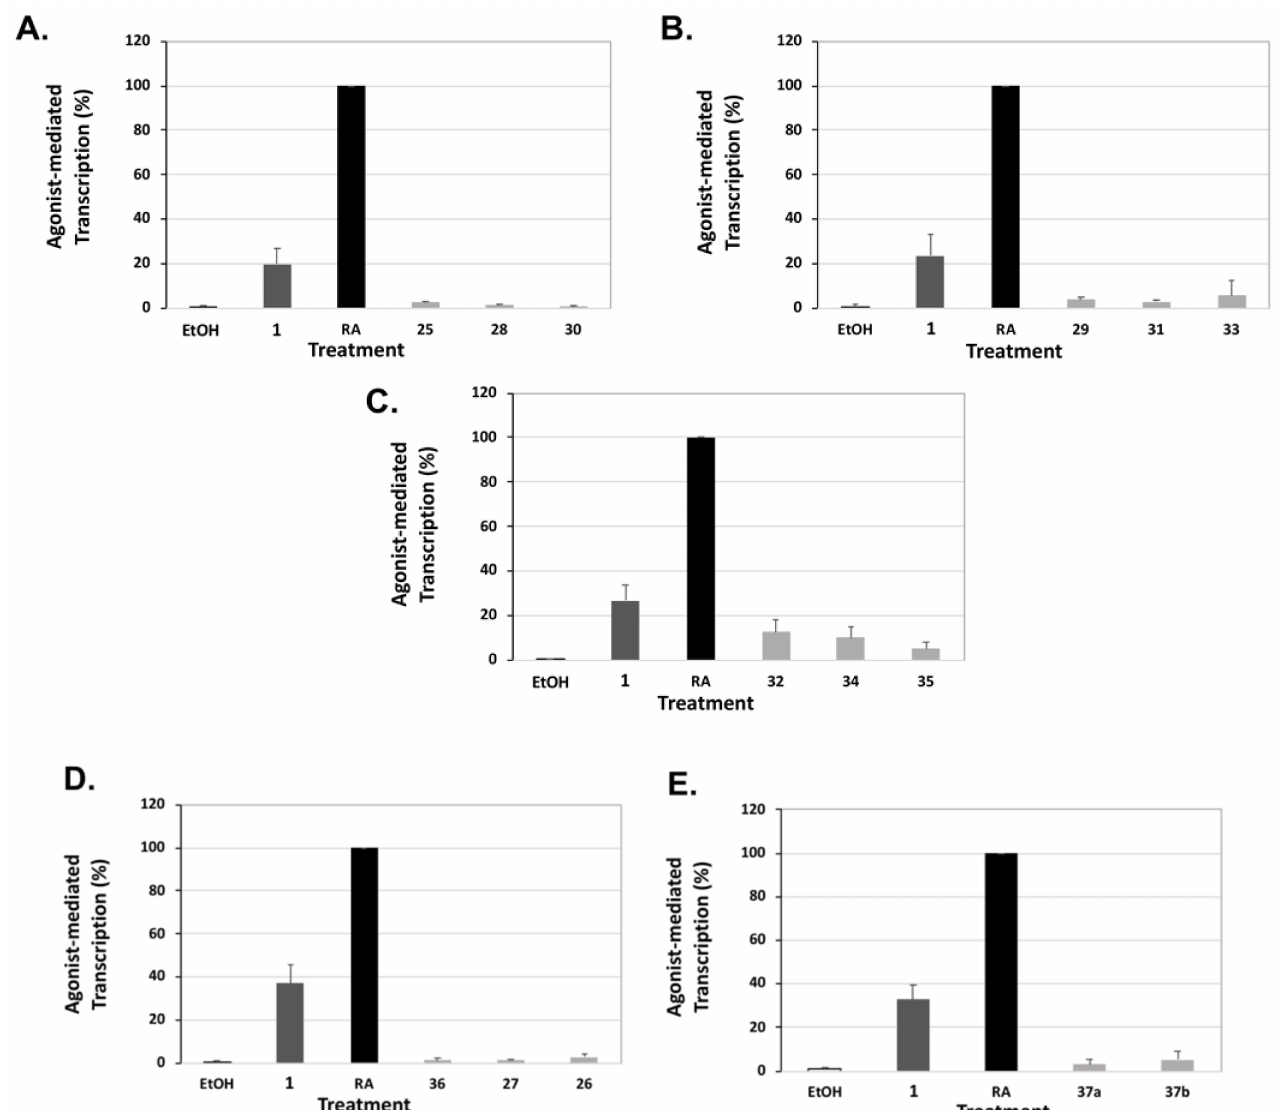
Figure 10. Assessment of RXR agonists via a RARE-luciferase reporter based assay in human cells. ( A – E ) Human embryonic cells (HEK293) were co-transfected with expression vectors for hRXR α , a RARE-luciferase reporter gene, and a renilla control plasmid for 24 h utilizing a liposome-mediated transfection protocol. Cells were treated with bexarotene, analog, or all-trans-retinoic acid (RA) at 10 nM for 24 h. The RARE activity for RA was set to 100%. Values are means ± SD with all analogs tested displaying lowered RARE activity vs. compound 1 ( p <